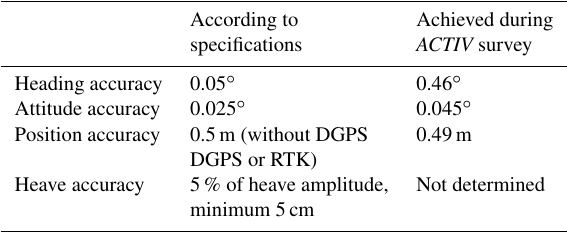
Table 2. Performance specifications of the F180R system.